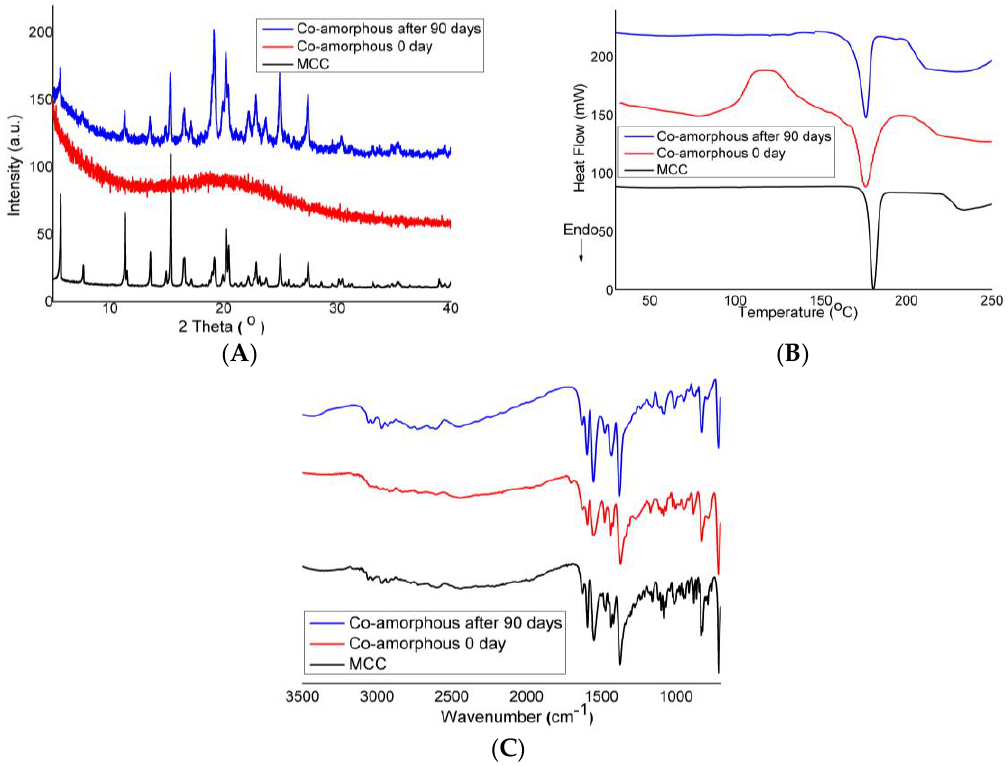
Figure 9. ( A ) PXRD diffractograms, ( B ) DSC thermograms and ( C ) FTIR spectra for multicomponent crystal (MCC) DES–BA (black line), co-amorphous DES–BA 0 day (red line), and co-amorphous DES–BA after 90 day (blue line).